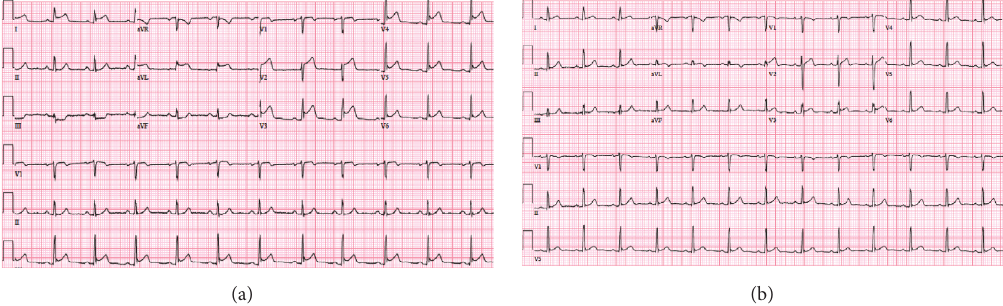
Figure 1: Acute anterolateral ST-segment elevation myocardial infarction (a). Note ST elevations in anterior precordial leads V2–V5, lateral limb leads I and aVL, and reciprocal changes in III and aVF. Resolution of ST-segment abnormalities and inferior reciprocal changes after sublingual nitroglycerin and intra-arterial nitroglycerin and verapamil at the time of angiography via radial sheath (b).